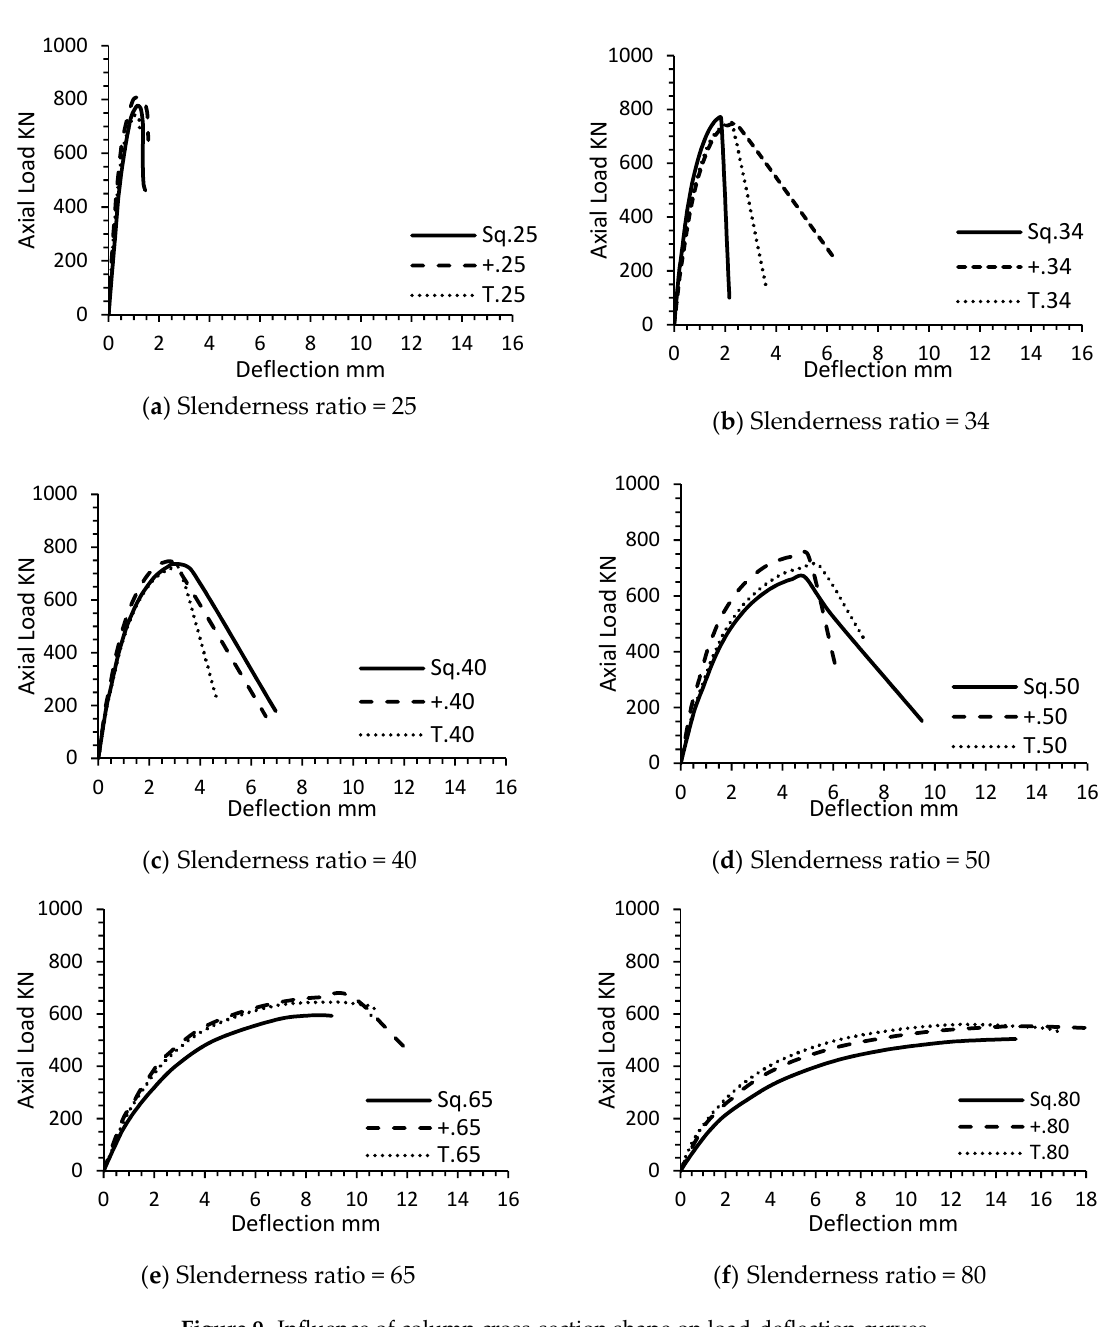
Figure 10. Comparison of stresses between specially shaped reinforced concrete (SSRC) and square- shaped columns for different SR.